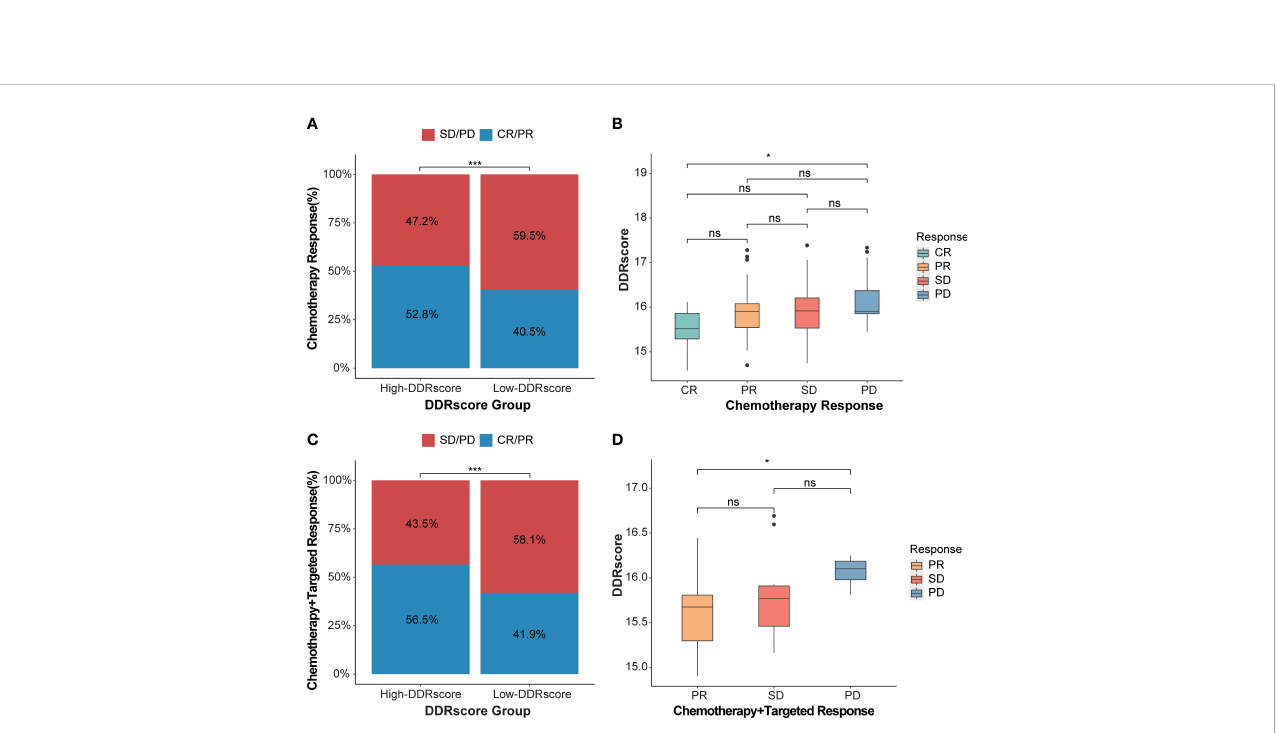
FIGURE 9 DDRscore model predicts the ef fi ciency of therapy response. (A) The proportion of chemotherapy response in high- versus low-DDRscore subgroups. (B) Distribution of DDRscore in chemotherapy alone response statuses. (C) The proportion of chemotherapy response in high- versus low-DDRscore subgroups. (D) Distribution of DDRscore in chemotherapy combined targeted therapy response statuses. CR, complete response; PR, partial response; SD, stable disease; PD, progressive disease. * Indicates P<0.05, ***Indicates P<0.001, ns indicates no signi fi cant